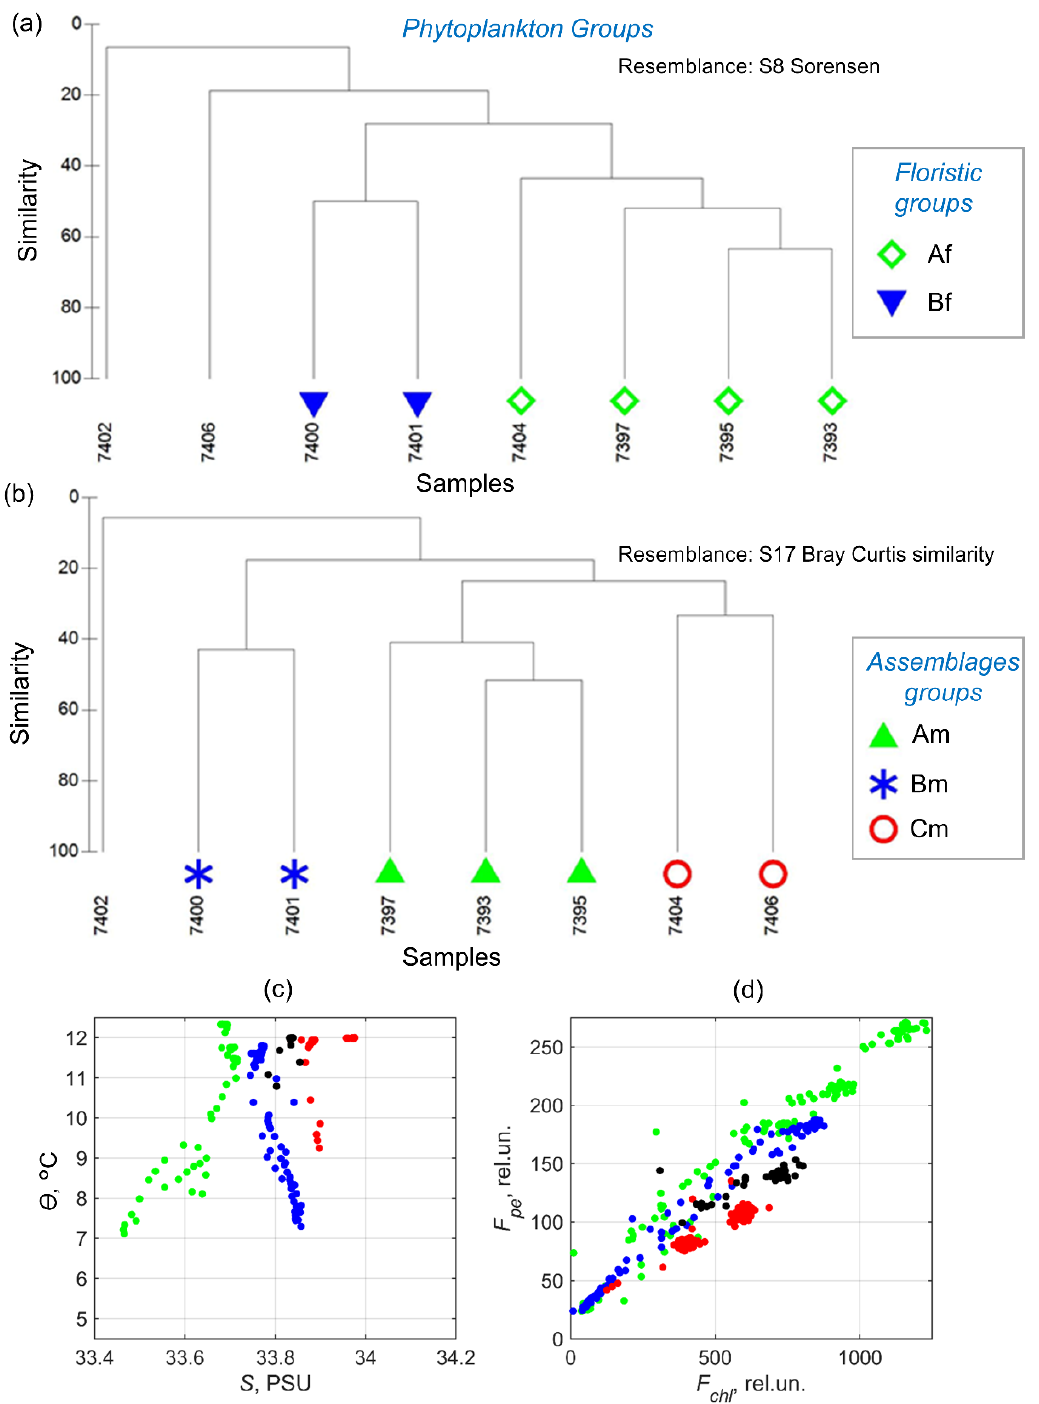
Figure 9. Dendrograms showing the grouping of phytoplankton communities according to qualitative features (floristic groups ( a )) and quantitative structure (groups of assemblages ( b )). Corresponding θ - S diagram ( c ) and “phycoerythrin—chl- a fluorescence intensity” scatter plot ( d ) for different phytoplankton assemblages where colors are associated with phytoplankton assemblage groups.